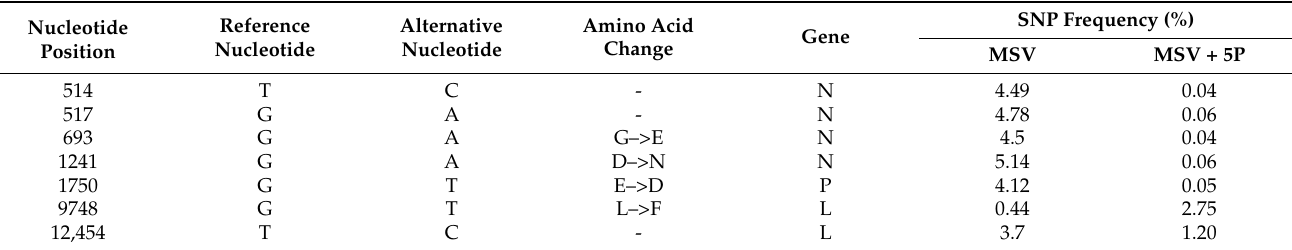
Table 2. Genomic location and frequency of variants in MSV and MSV after 5th passage (MSV + 5P) in adherent cell culture. For MSV + 5P, the SNP frequencies below 2.5% are presented for the comparison of variant evolution.